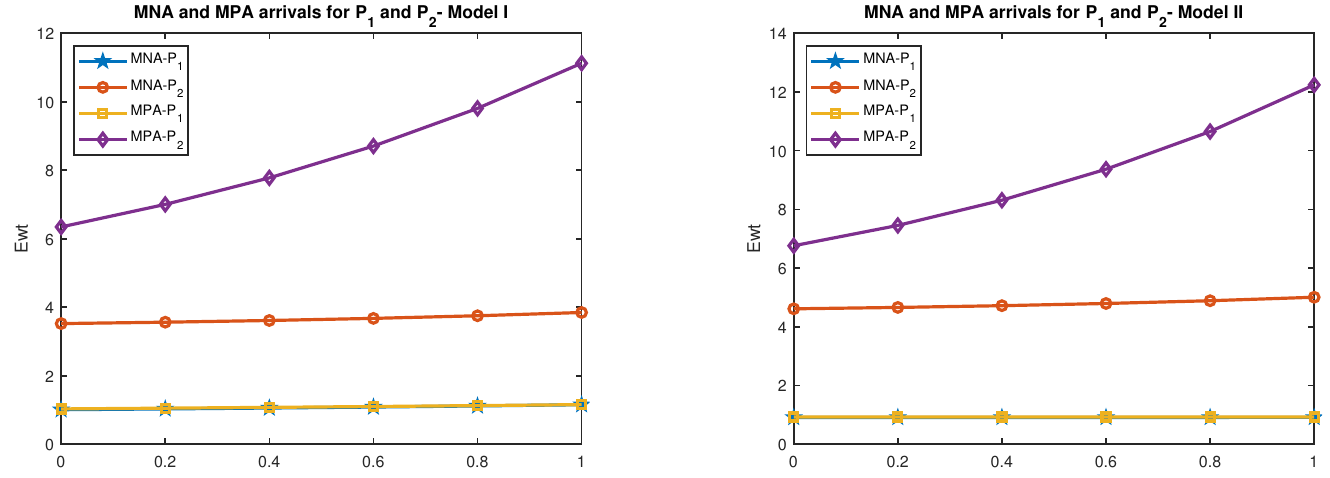
Figure 4. Effect of θ on expected waiting time of P 1 and P 2 customers in the system for MNA and MPA arrival processes with correlation of − 0.4211 and 0.4211, respectively (when L =